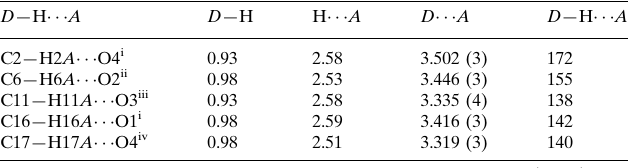
Hydrogen-bond geometry (A˚ , (cid:1)